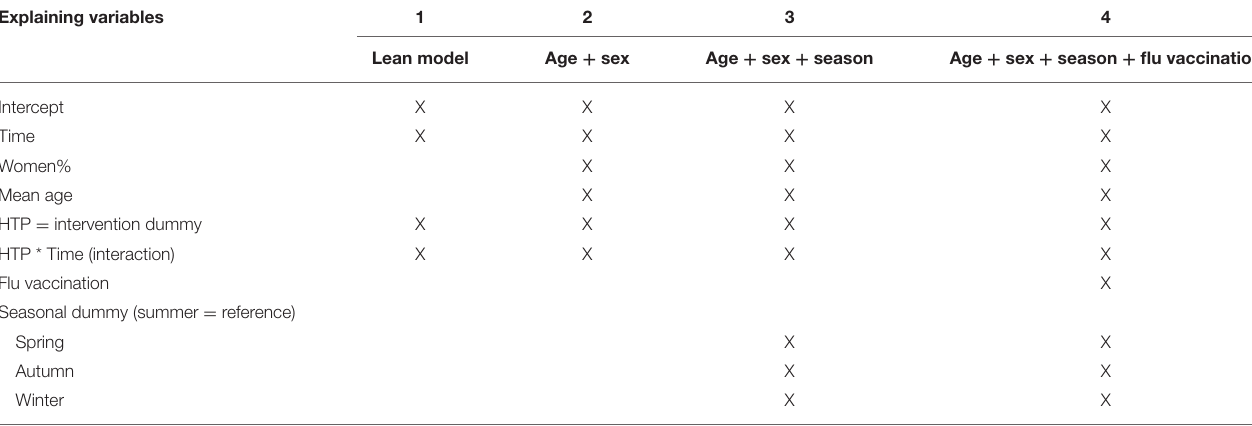
TABLE 1 | Overview of interrupted time-series model